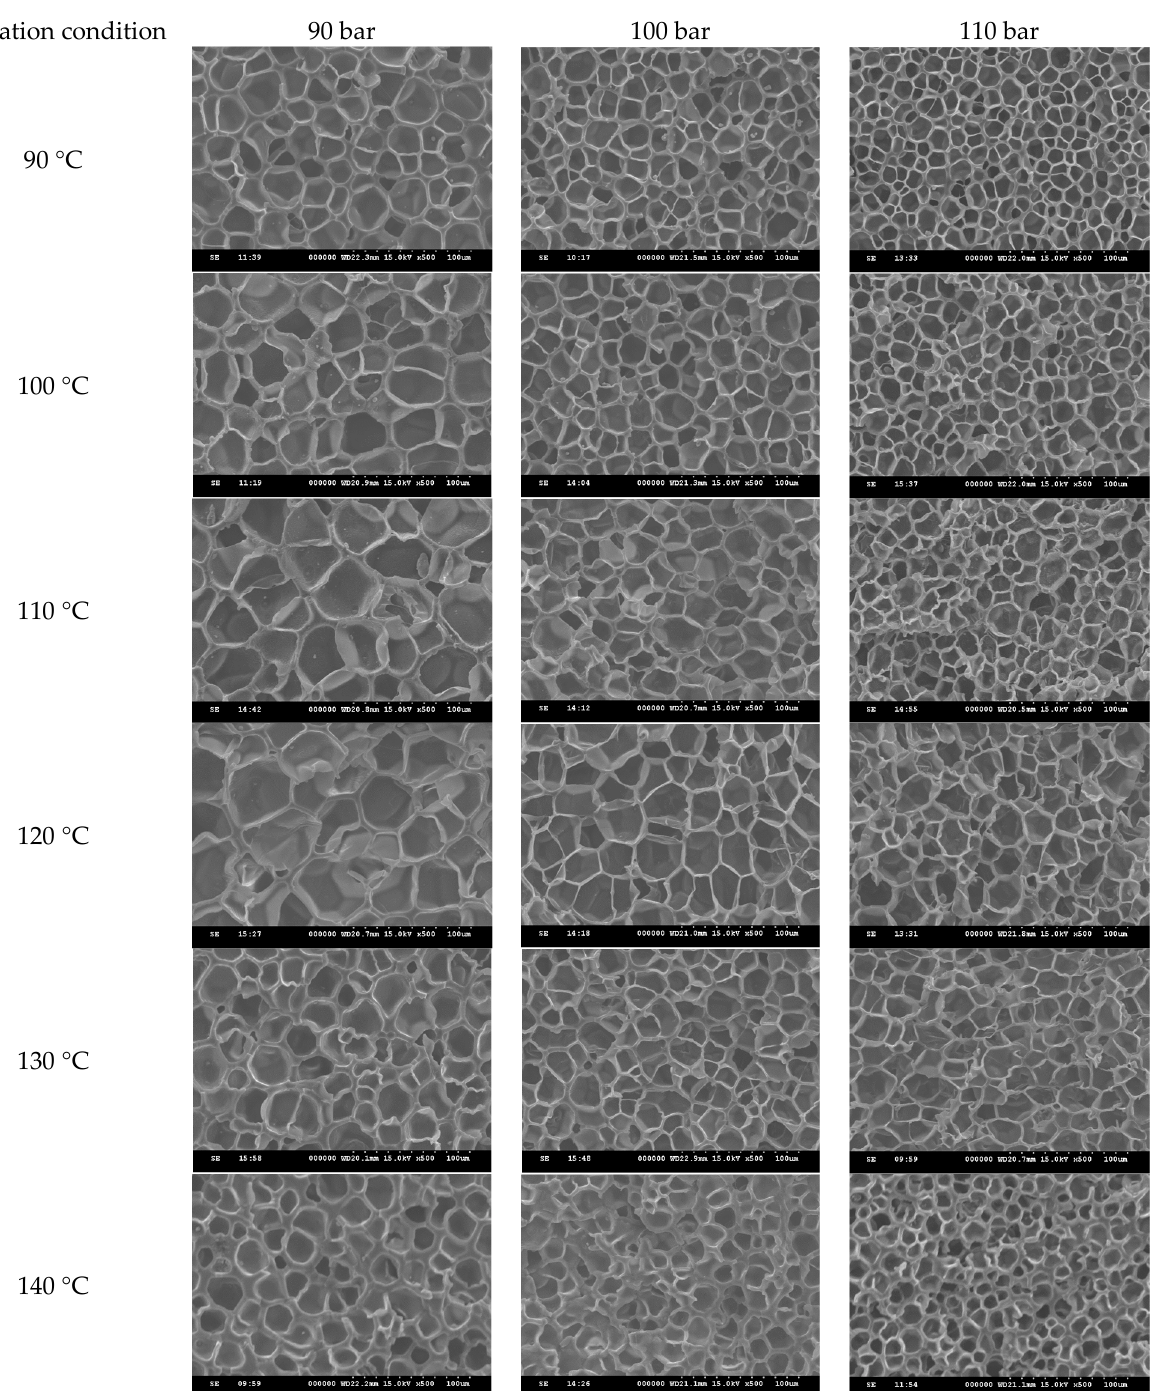
Figure 7. Comparison of cell structure of TPU foams obtained from different saturation temperature and saturation pressure.